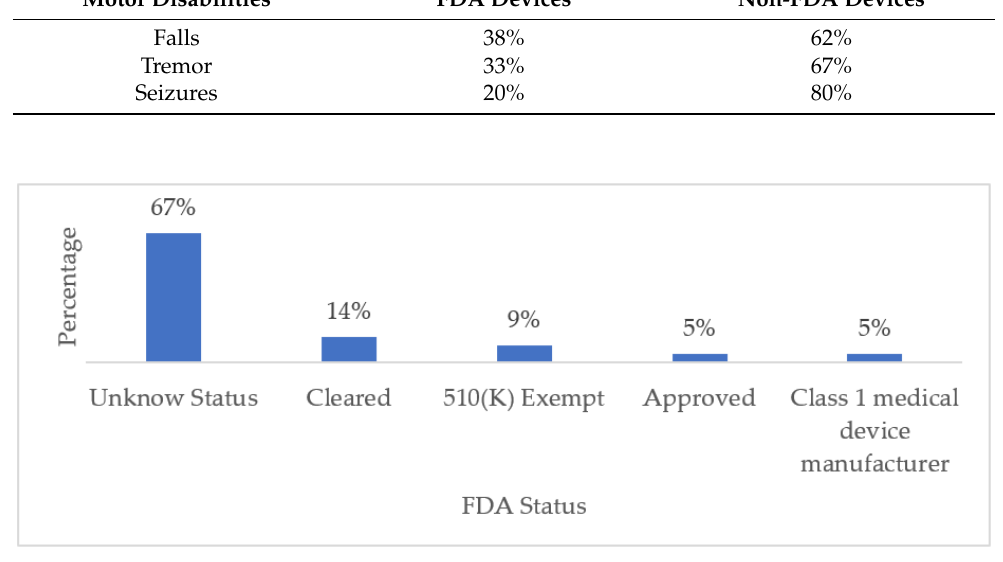
Figure 8. FDA Status of Commercial Wearables Used for Monitoring NDD-Related Motor Impair- ments.